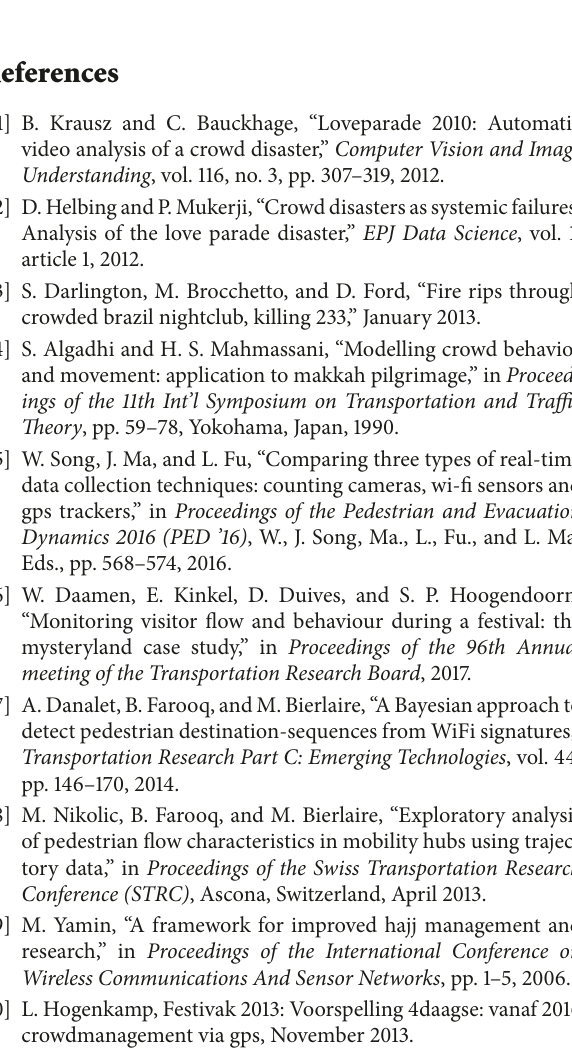
Figure 11: Cumulative number of pedestrians on the Dam during the first weekend of the Europride